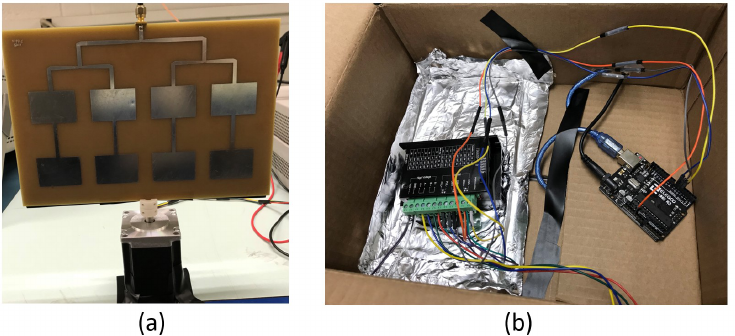
Figure 1. ( a ) Prototype of 2 × 4 MPAA, ( b ) stepper motor driver and controller circuit connected to the MPAA.